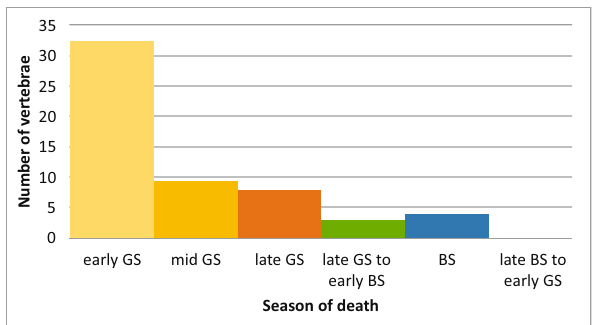
Figure 9: Distribution of identi fi ed season of death on a sample of 57 fi sh vertebrae from layer 3; GS = good season, BS = bad season.